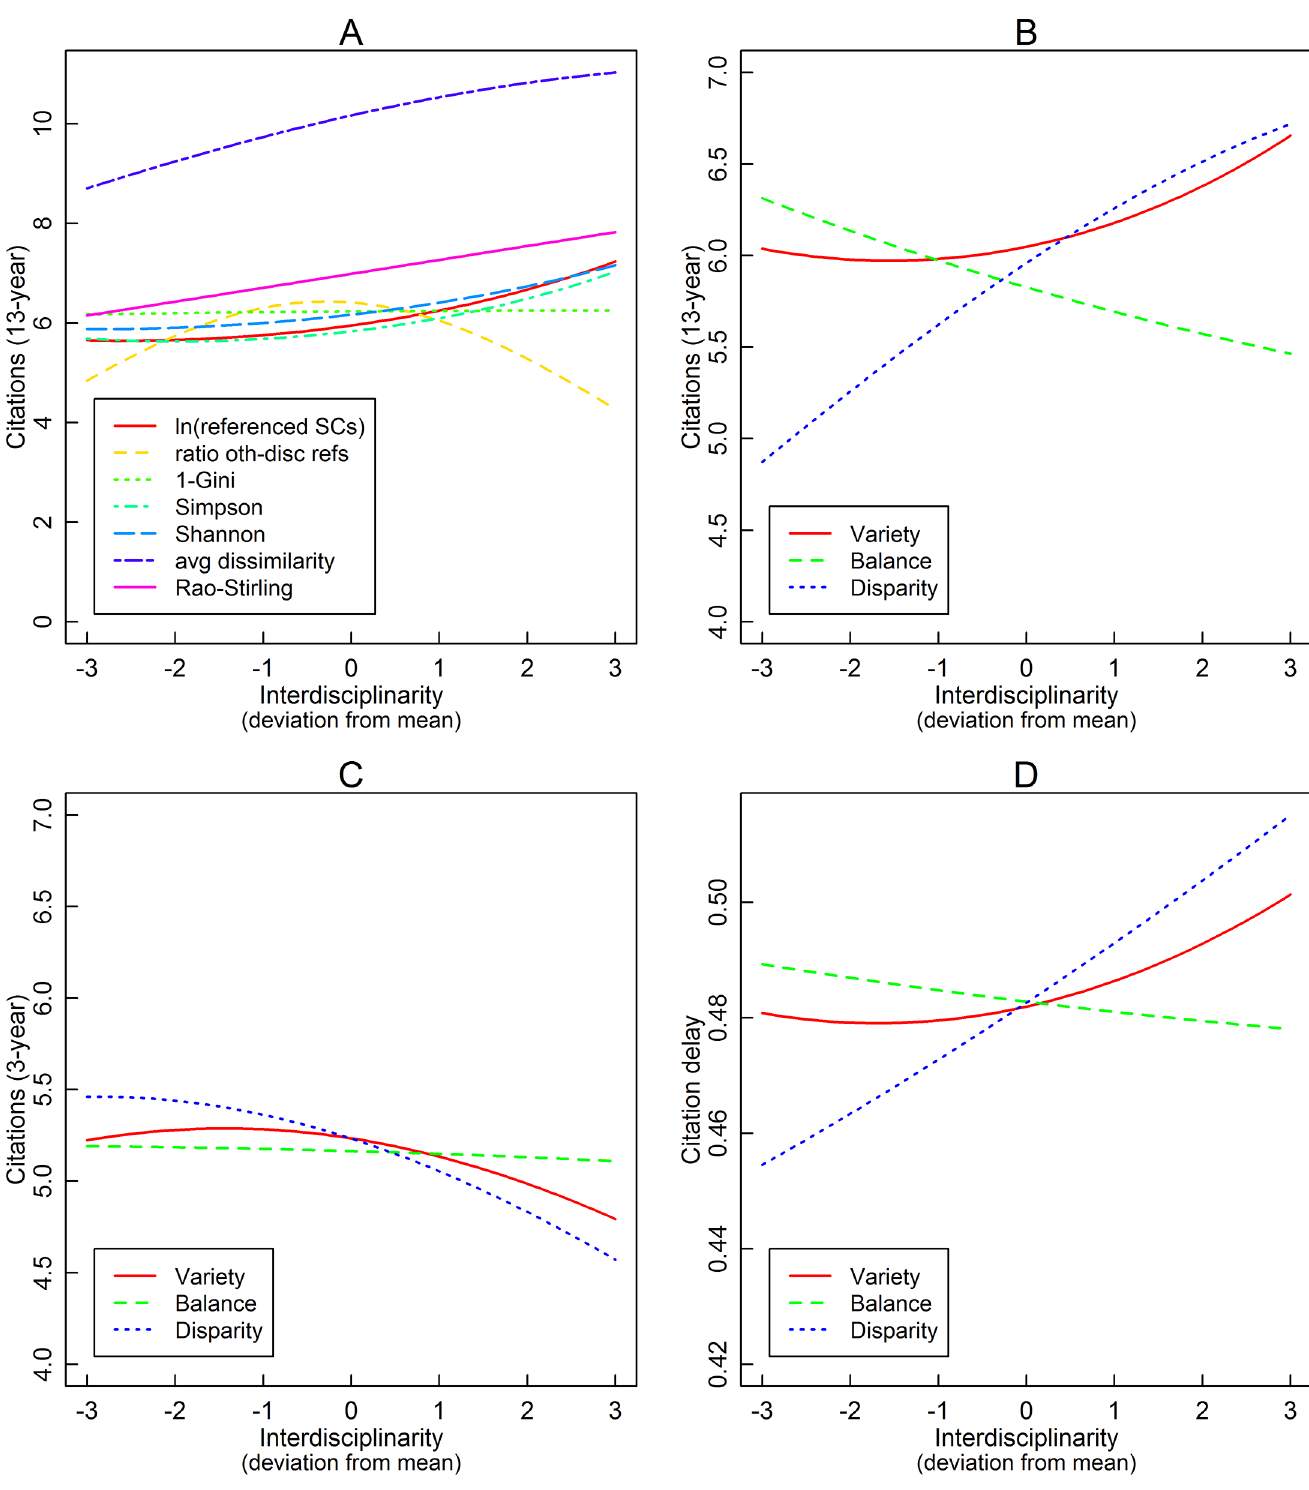
Fig 2. Interdisciplinarity and Citations. Data sourced from Thomson Reuters Web of Science Core Collection.